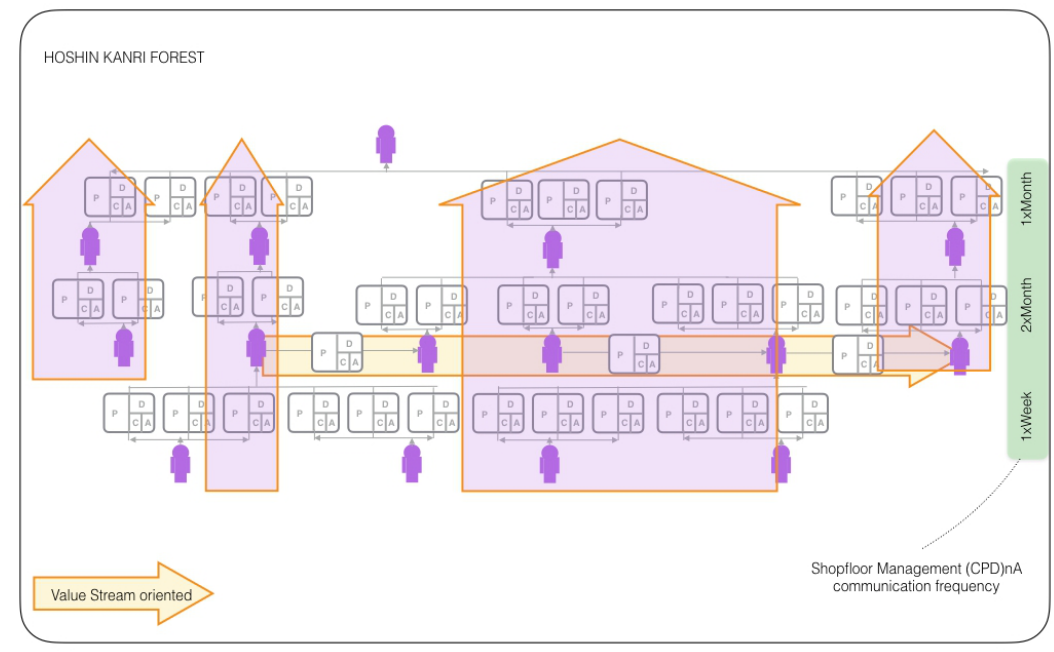
Figure 1. Hoshin Kanri Forest Structure